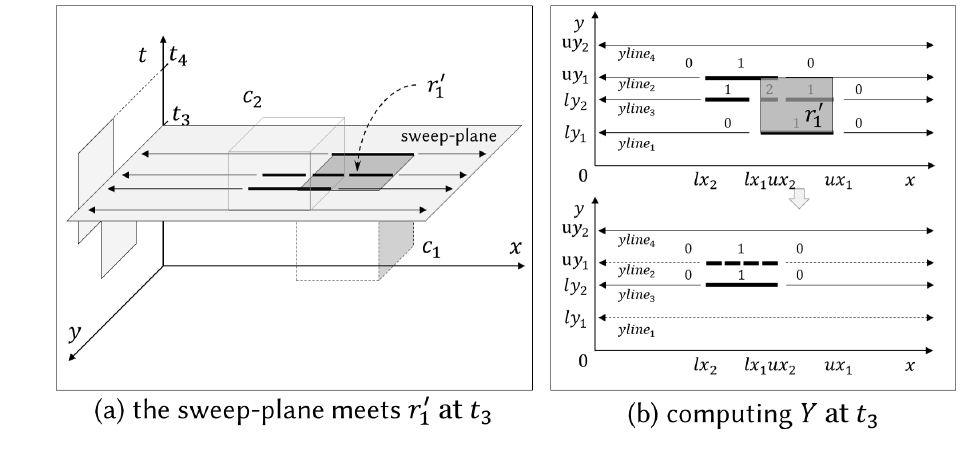
Figure 7. Sweep-plane encounters r 3 at t 3 .